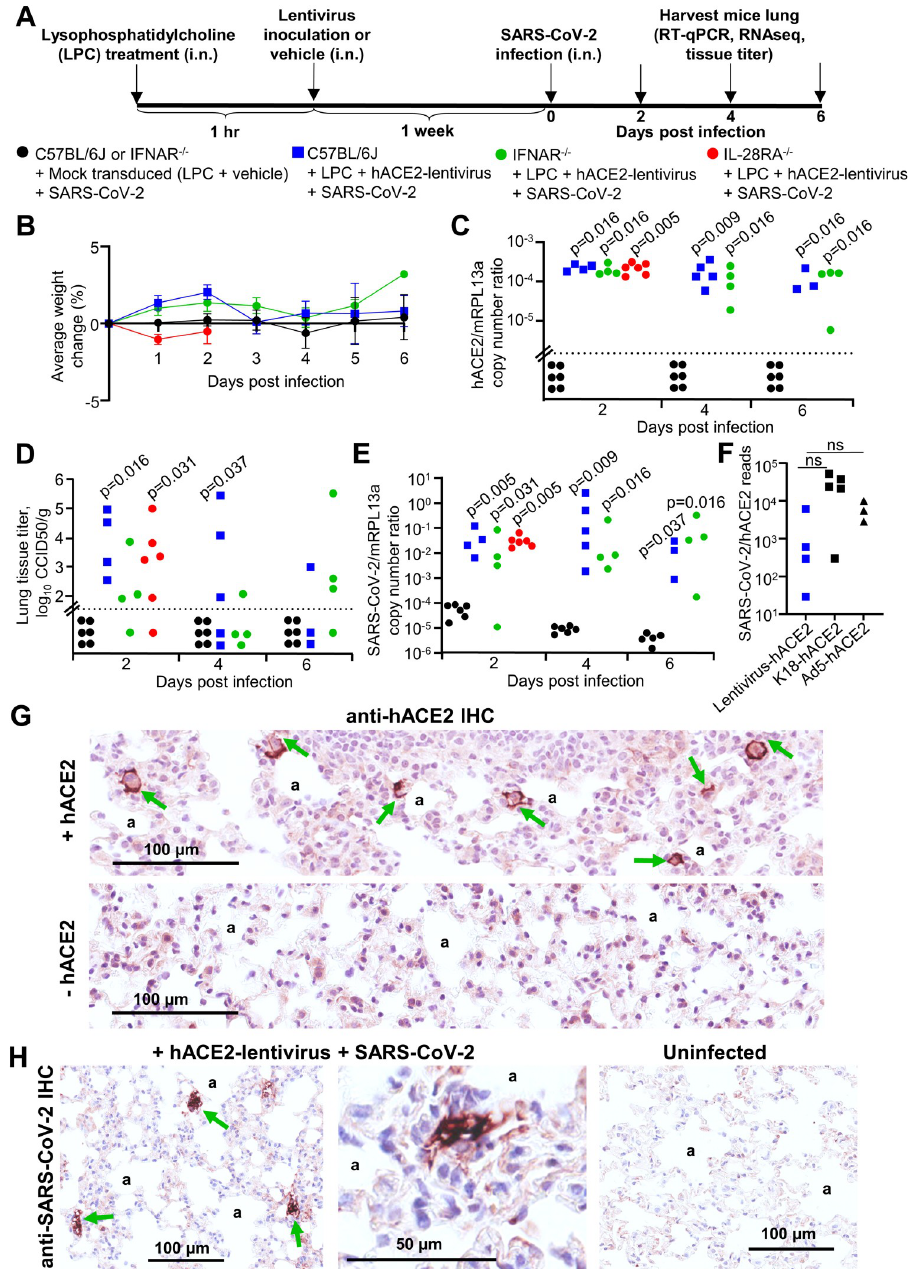
Fig 2. SARS-CoV-2 replication in hACE2-lentivirus transduced C57BL/6J, IFNAR -/- and IL-28RA -/- mouse lungs. A) Timeline of lentivirus transduction of mouse lungs and SARS-CoV-2 infection. B) Percent weight change for mice in C-E (mock transduced mice, n = 6 at each time point. C57BL/6J mice, n = 4 at day 2, n = 5 at day 4, n = 3 at day 6. IFNAR -/- mice, n = 4 at each time point. IL-28RA -/- , n = 6 at day 2). Data represents the mean percent weight loss from day 0 and error bars represent SEM. C) RT-qPCR of mouse lungs RNA using primers for hACE2 (introduced by lentivirus transduction) normalized to mRPL13a levels. Data is for individual mice and is expressed as RNA copy number calculated against a standard curve for each gene. Horizontal line indicates cut-off for reliable detection, with all mock transduced mice falling below this line. Statistics are by Kolmogorov Smirnov test compared to mock transduced samples. D) Titer of SARS-CoV-2 in mouse lungs determined using CCID 50 assay of lung homogenates. Horizontal line indicates the limit of detection of 1.57 log 10 CCID 50 /g. Statistics are by Kolmogorov Smirnov test compared to mock transduced mice. IFNAR -/- versus mock transduced mice at day 2 post infection reaches significance by Kruskal-Wallis test (p = 0.018). E) RT-qPCR of mouse lung RNA using primers for SARS-CoV-2 E